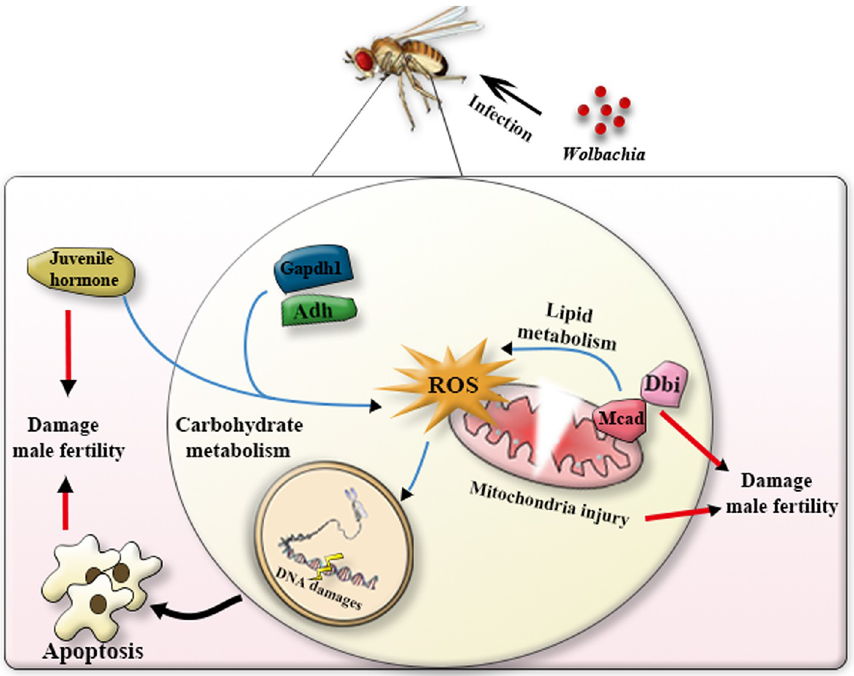
Fig 10. A simple model showing that Wolbachia -induced energy output in 1d males affects male fertility in D . melanogaster